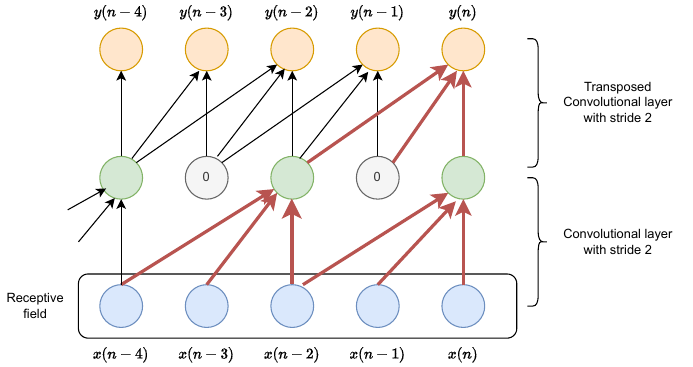
Figure 3. A schematic illustration of dependence in time axis for the composition of convolutional layer with a stride equal to 2 and a transposed convolution with a stride of 2.